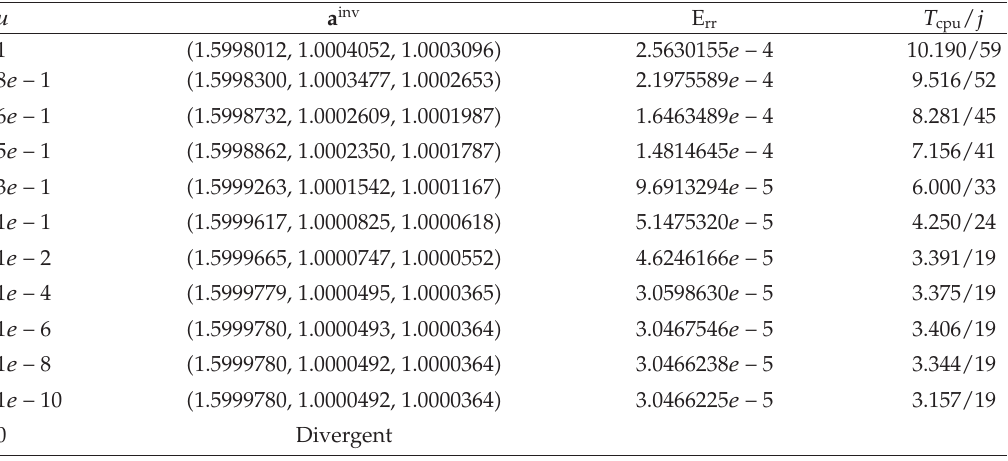
Table 3: Influence of regularization parameter on the algorithm with τ (cid:8) 0 .